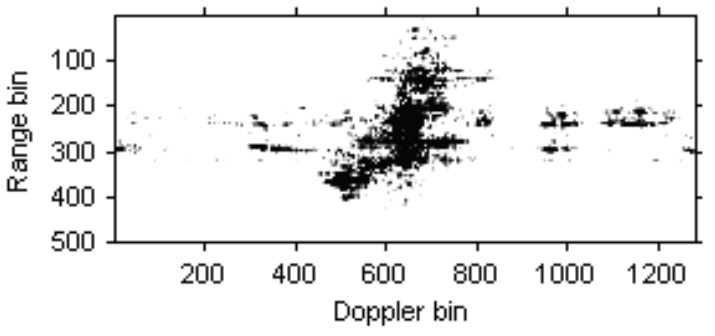
Figure 5. ISAR image based on the RD